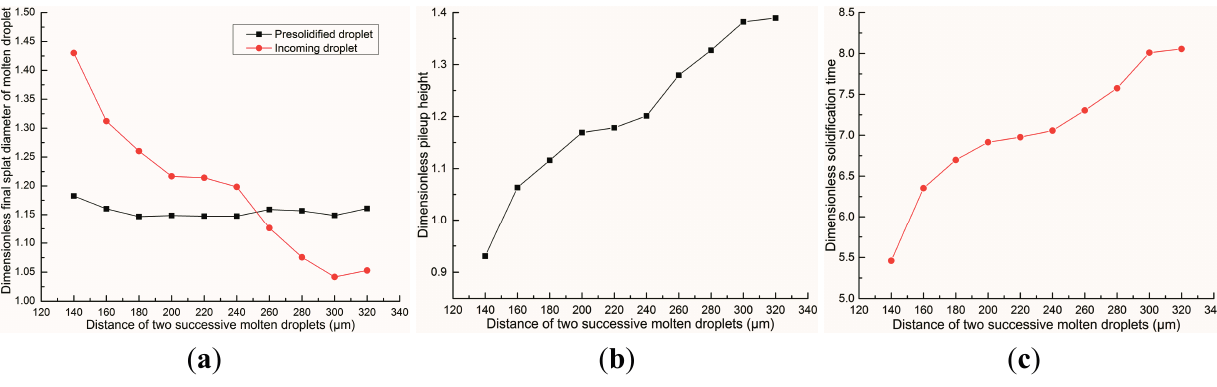
Figure 9. Variation in ( a ) dimensionless final splat diameter, ( b ) dimensionless pileup height, and ( c ) dimensionless solidification time with the distance between two successive